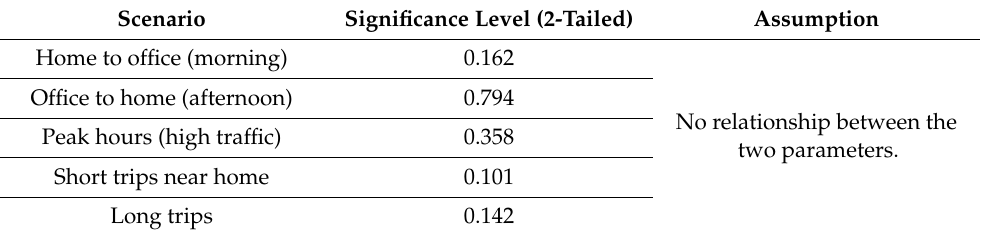
Table 7. Results of bivariate correlation analysis for energy requirement vs. battery charge. Scenario Significance Level (2-Tailed)